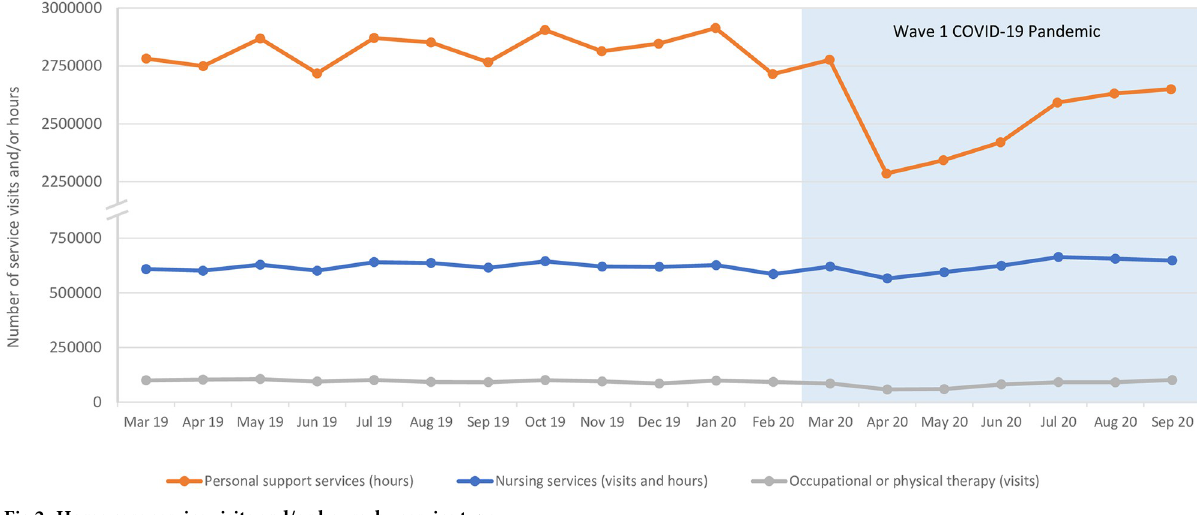
Fig 2. Home care service visits and/or hours, by service